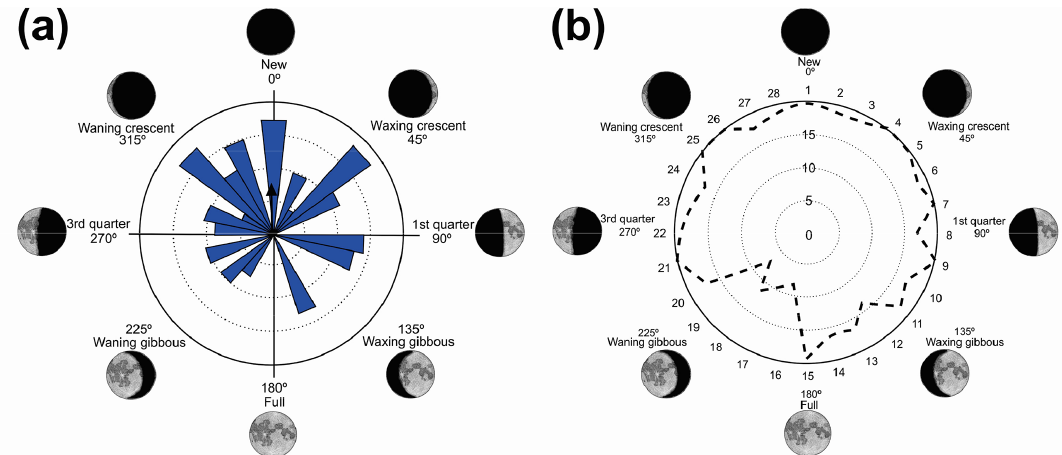
Figure 1. (a) Vocalization activity of the sample consisting of N = 1691 individuals of 37 species and distribution of the respective synodic cycles throughout the sampling period. (b) Kiviat diagram in von Mises distribution revealing the relationship between the anuran activity and the lunar cycle. The dashed line represents the relative value of active